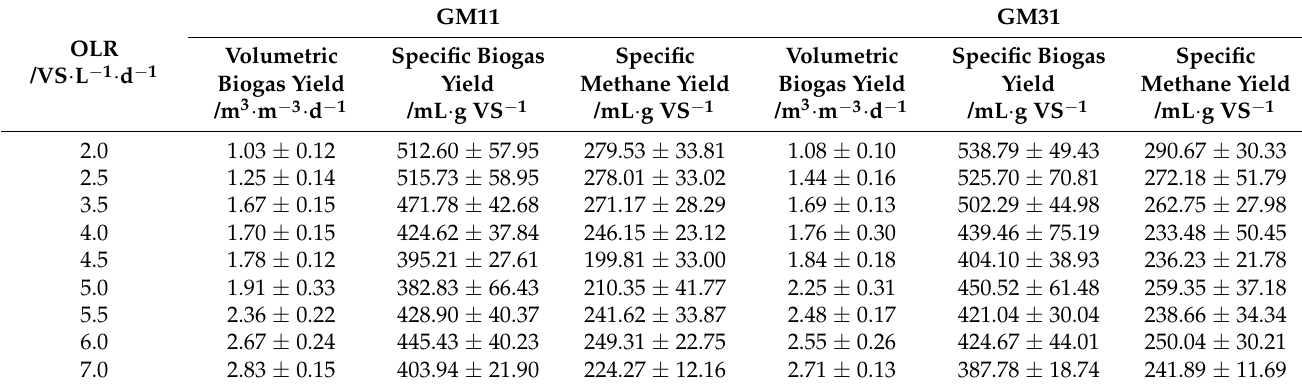
Table 2. Anaerobic digestion performance of GM11 and GM31 at semi-continuous